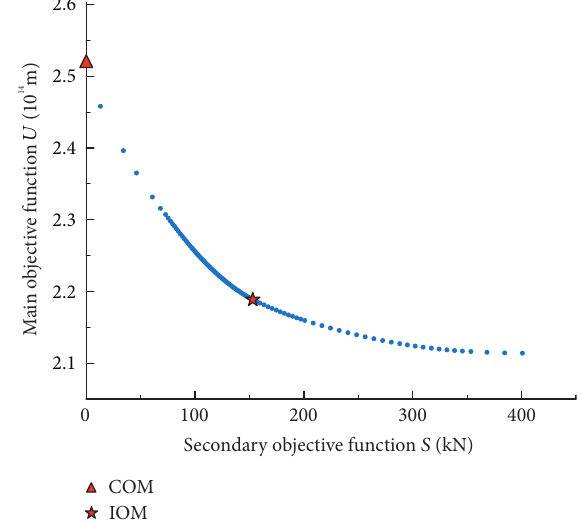
Figure 6: Pareto pioneer point of U – S .